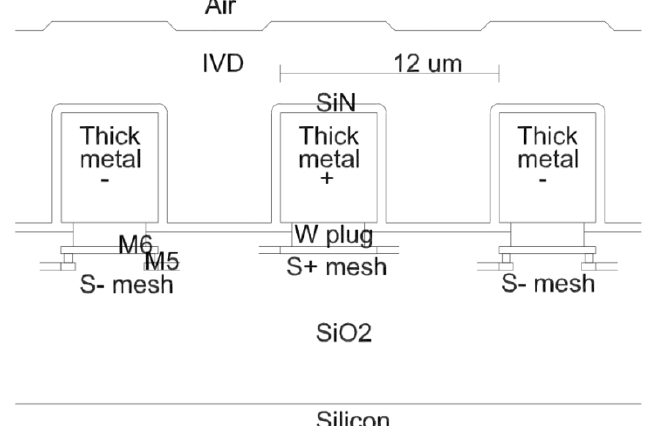
Figure 1. Side-view cross-section of the humidity